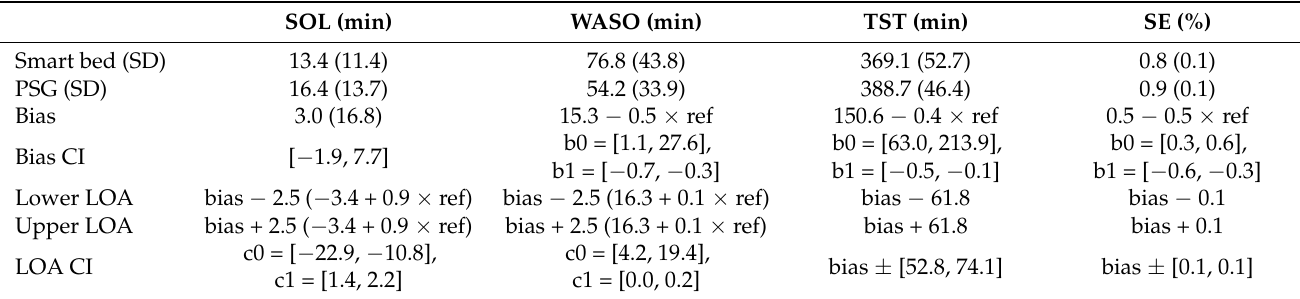
Table 3. Comparison of smart bed- and PSG-derived overnight sleep variables.